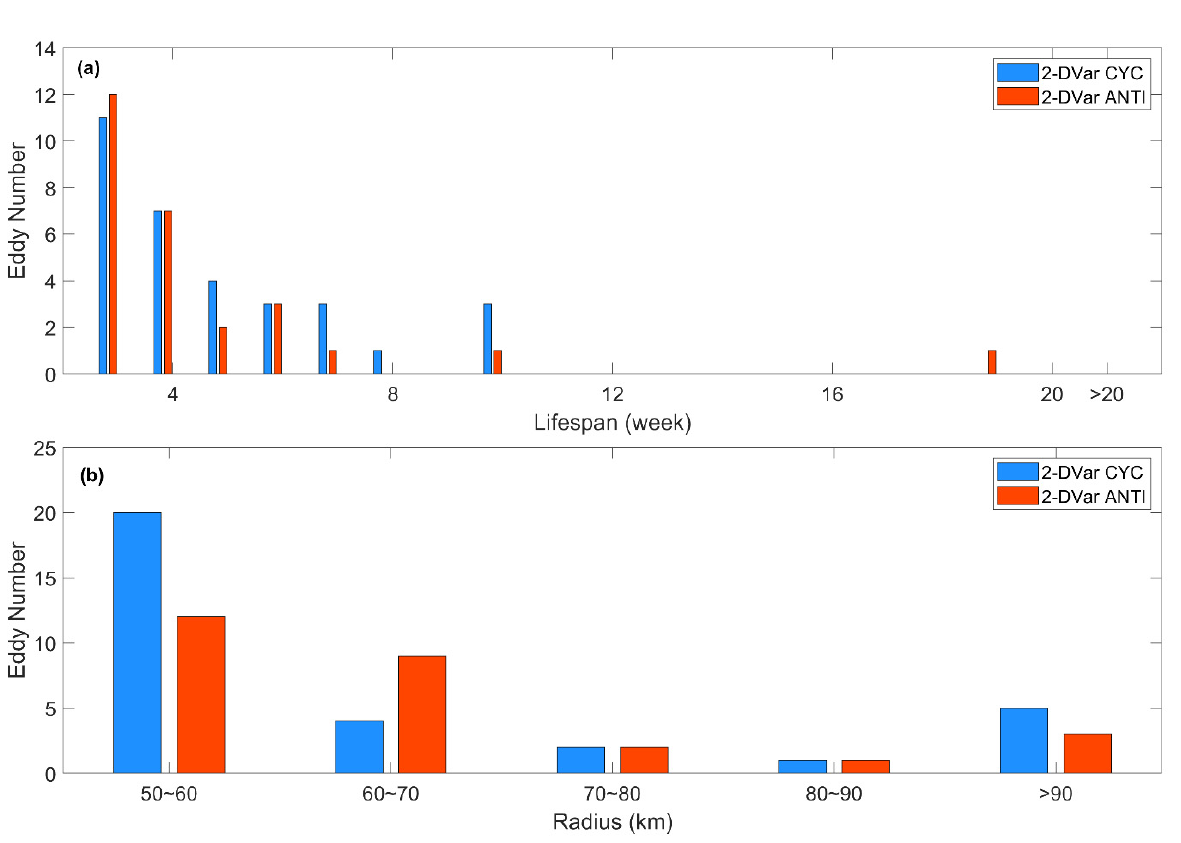
Figure 12. Histograms of ( a ) eddy lifespan, where “>20” represents the total number of eddies with a lifespan greater than 20 weeks and ( b ) eddy radii, where “>90” represents the total number of eddies with a radius larger than 90 km.